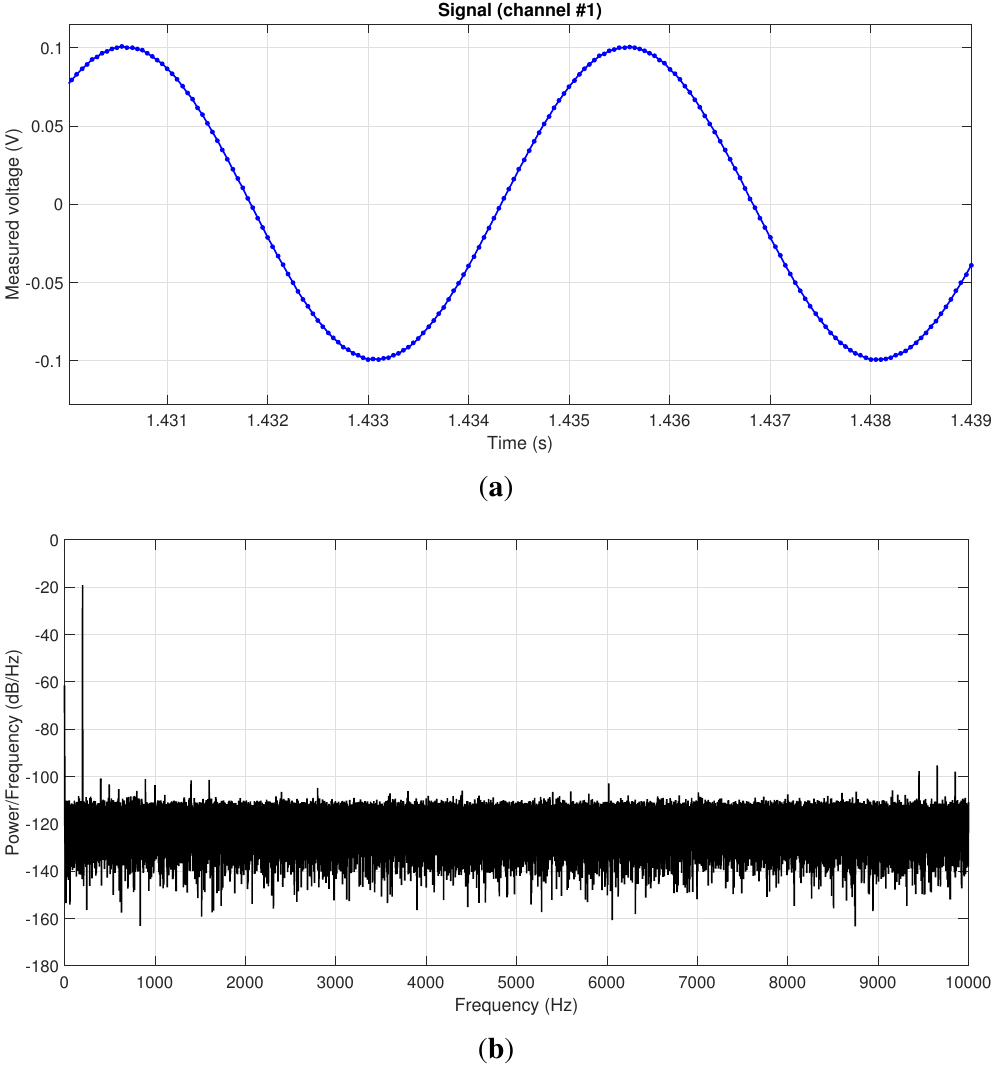
Figure 4. The results for a test consisting of feeding a 200 Hz sinusoidal signal into a 16-bit ADC DAQ module, are shown in ( a ) and ( b ) in the time and frequency domains (with Hanning windowing),